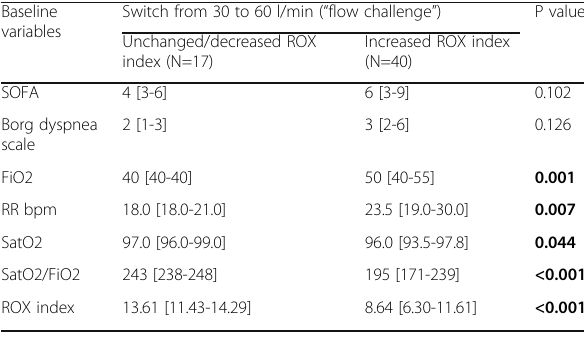
Table 1 (abstract 0434). Physiological variables divided according to ROX index change from baseline (30 l/min).Values are reported as means±std or medians [IQR]